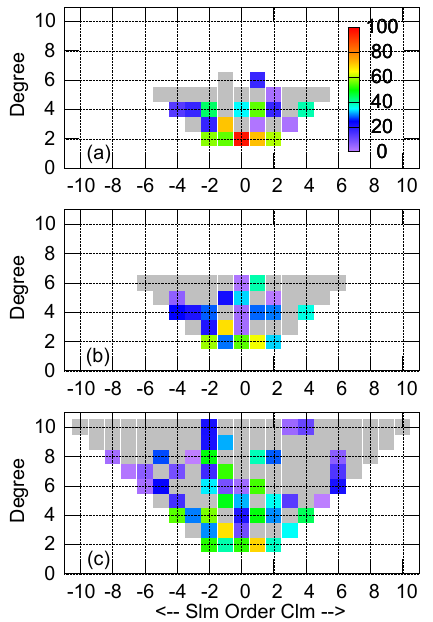
Figure 1. Percent of GRACE variance explained by three SLR time series, after a 200-day smoother has been applied. SLR series are (a) Cheng et al’s 5 × 5 series, (b) So´snica et al’s 6 × 6 unconstrained series, and (c) So´snica et al’s 10 × 10 constrained series. Harmon- ics with negative percent variance explain are shaded in grey. The C 20 term in (a) is a perfect 1.0, because the GRACE C 20 has been replaced by the SLR value. S harmonics are denoted as negative orders along the x axis, while C terms are listed as positive ones.